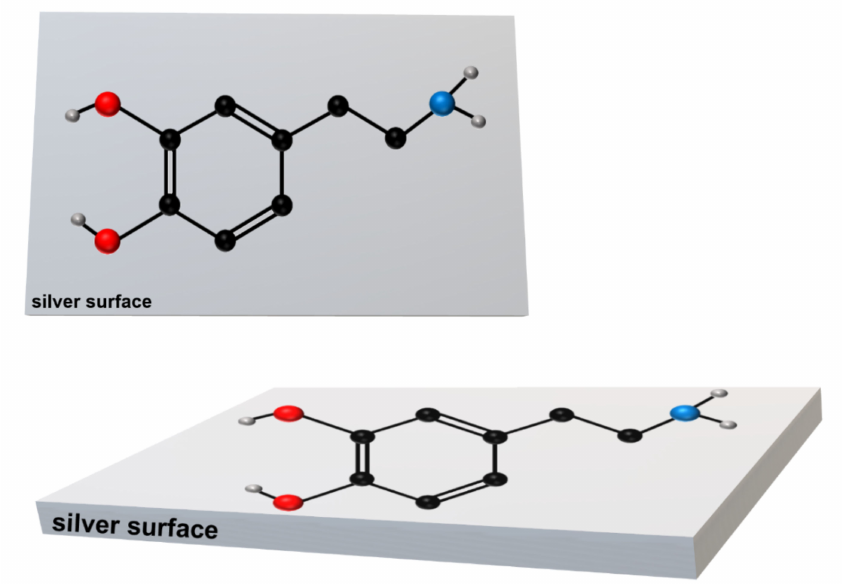
Figure 4. Schematic drawing of the dopamine molecule adsorbed on the silver surface from the aqueous solution to which no additional electrolytes have been added. The aromatic ring of dopamine adopts a flat orientation versus the silver surface. Upper drawing: view from above; bottom drawing: side